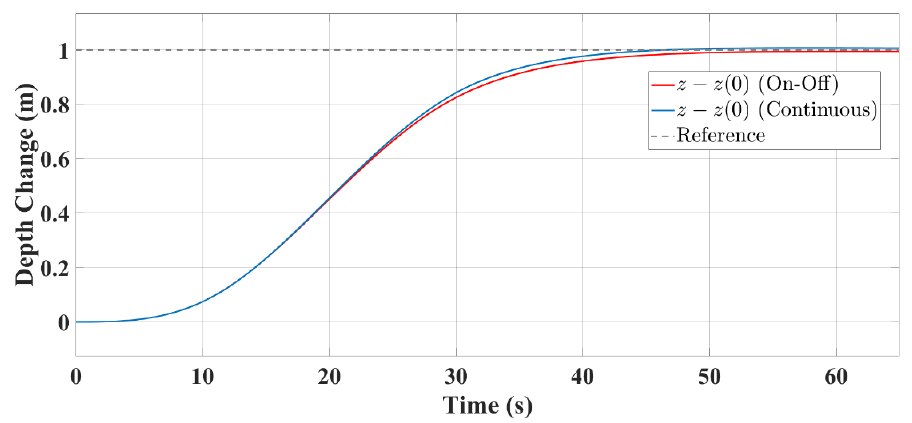
Figure 9. Depth change responses of on-off and continuous type VBS control.